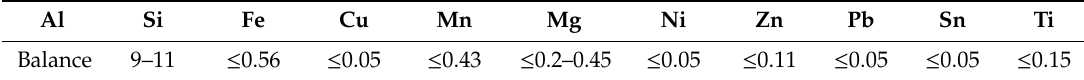
Table 1. Chemical composition (wt.%) of the AlSi10Mg